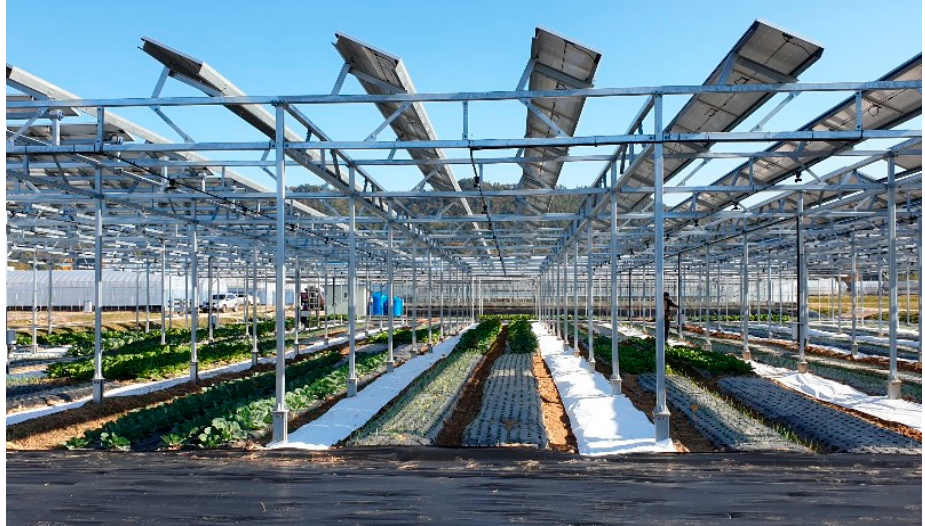
Figure 1. Farm-type photovoltaic-power-generation system.